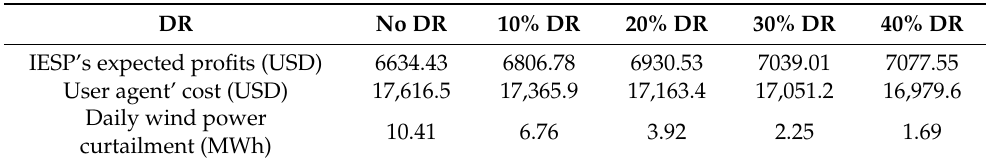
Table 3. Impact of demand response on IESP’s expected profits, user agent’s cost and daily wind power